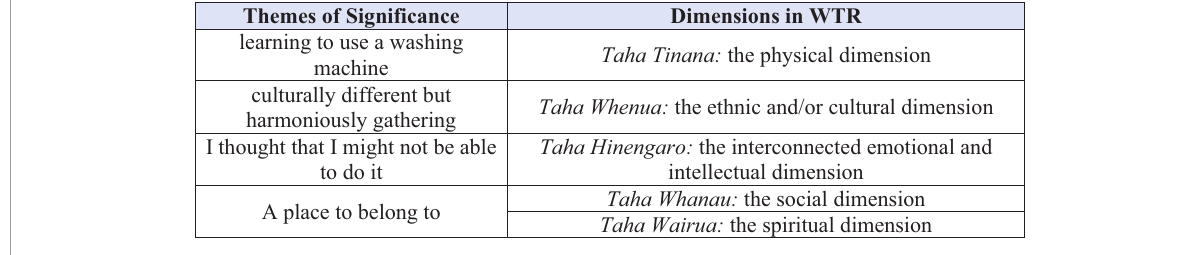
Taha Tinana: Learning to use a washing